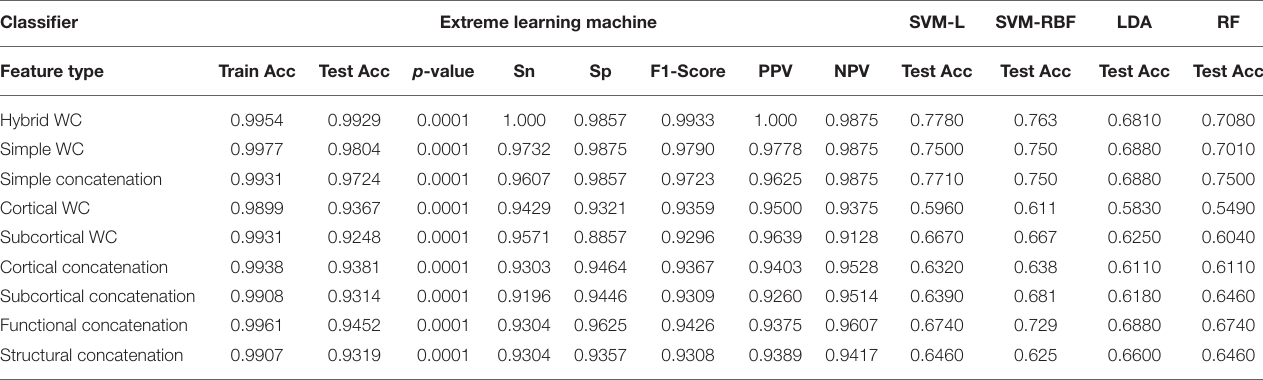
TABLE 4 | Mean classification performance of multimodal features.